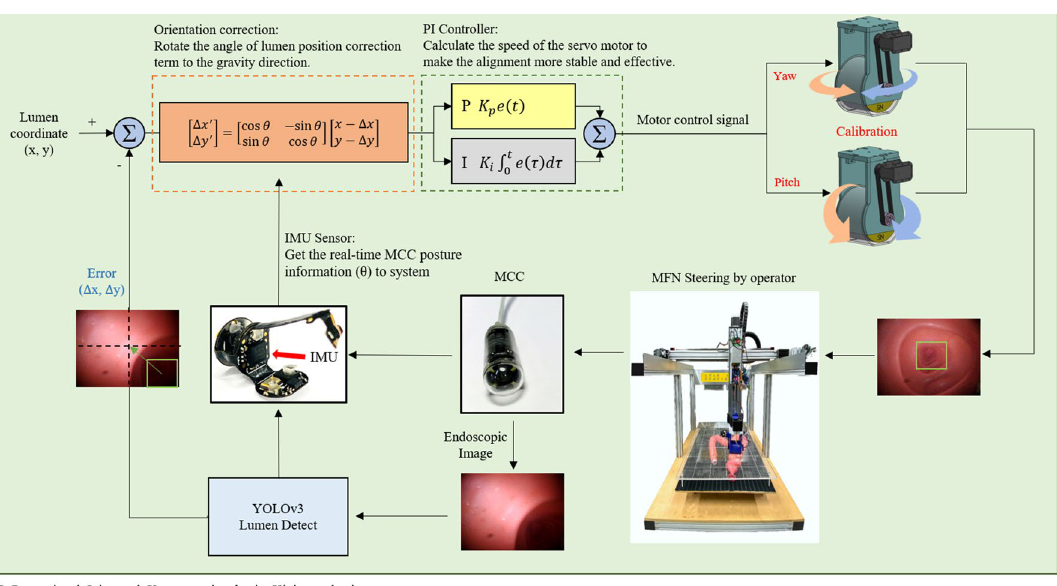
Figure 6. Control block diagram for alignment experiment with the MACC system. Using the calibration error between the lumen position and the image center, real-time posture information of the MCC was sent to the orientation correction and PI controller. The MFN calibrated by yaw angle and pitch angle according to instructions given by control signal from PI controller until the calibration error reached the predefined threshold. P proportional, I integral, Kp proportional gain, Ki integral